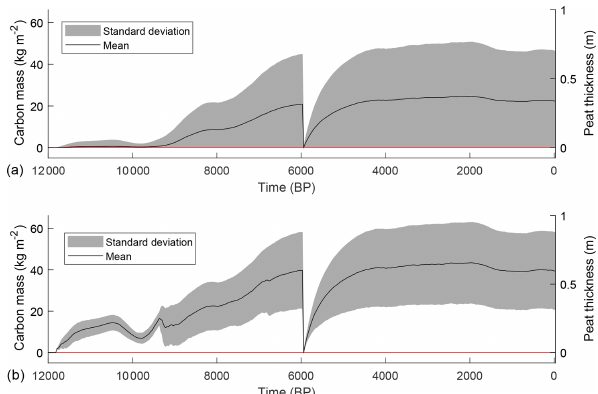
Figure 16. Simulated mean peat thickness/carbon mass and stan- dard deviation for all grid points (a) and for the grid points with peat cover (b) , with a removal of all peat cover within the study area at